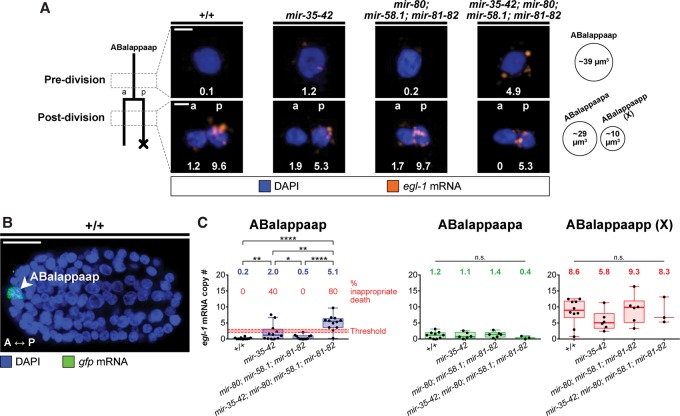
egl-1 mRNA copy number crosses a threshold to trigger the precocious death of ABalappaap in mir-35 mir-58 double-family mutants. (A) smRNA FISH analysis in the ABalappaap lineage. The lineage is illustrated at the right, with the approximate time of each analysis (pre- and post-division) indicated. Representative images of the ABalappaap cell and its daughters are shown for each time point in four genetic backgrounds, as indicated. The egl-1 mRNA copy number corresponding to each image is given. Nuclei are labeled as belonging to the surviving daughter (anterior [a]) or the dying daughter (posterior [p]). Approximate cellular volumes are given at the right. Bars, 2 µm. (B) A fixed wild-type embryo showing the ABalappaap cell (arrowhead) as identified by smRNA FISH staining against mRNA transcribed from the Punc-3unc-3::gfp reporter. The anterior–posterior axis (A ↔ P) is indicated. Bar, 10 µm. (C) Quantification of egl-1 mRNA copy number in the ABalappaap cell and its two daughters (ABalappaapa and ABalappaapp [X]) for each of the indicated genotypes. An estimated threshold for triggering cell death in ABalappaap is represented by the red line. The mean value is given above each data set. Box and whiskers were plotted according to Tukey's test. (*) P < 0.05; (**) P < 0.01; (****) P < 0.0001 via Mann-Whitney test. The following alleles were used: mir-35-41(nDf50), mir-42 (nDf49), mir-80(nDf53), mir-58.1(n4640), and mir-81-82(nDf54). All strains analyzed carried the extrachromosomal array xdEx1091 [Punc-3unc-3::gfp+Psur-5rfp].